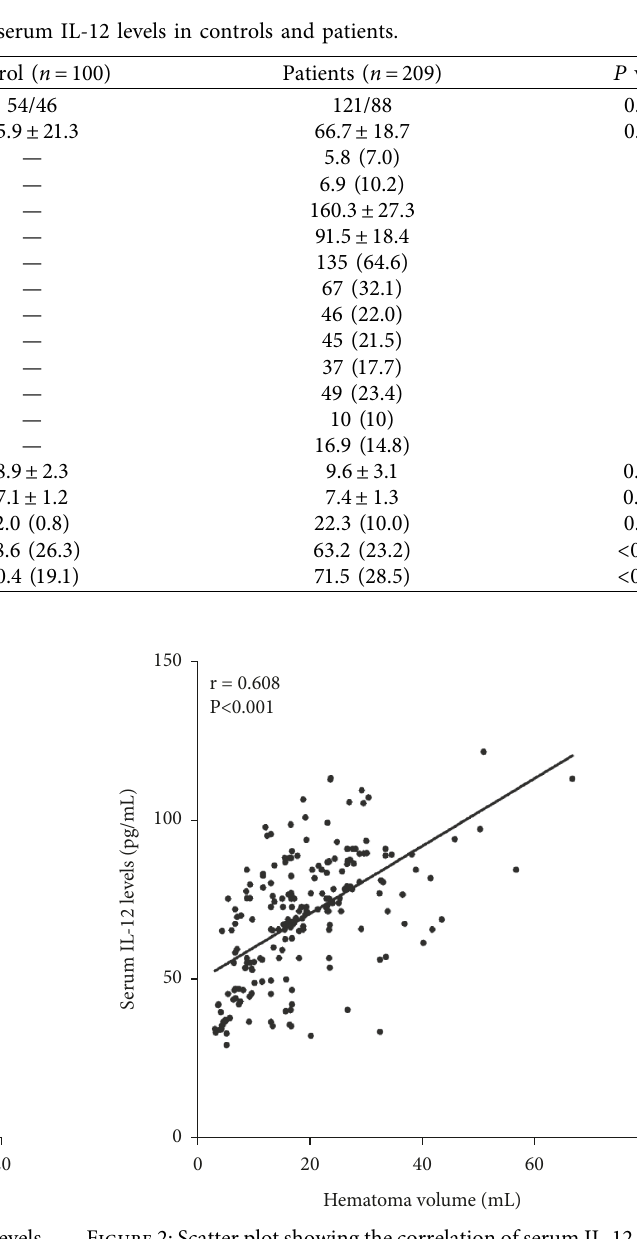
Figure 1: Scatter plot showing the correlation of serum IL-12 levels with NIHSS scores using Spearman’s correlation coefficient.